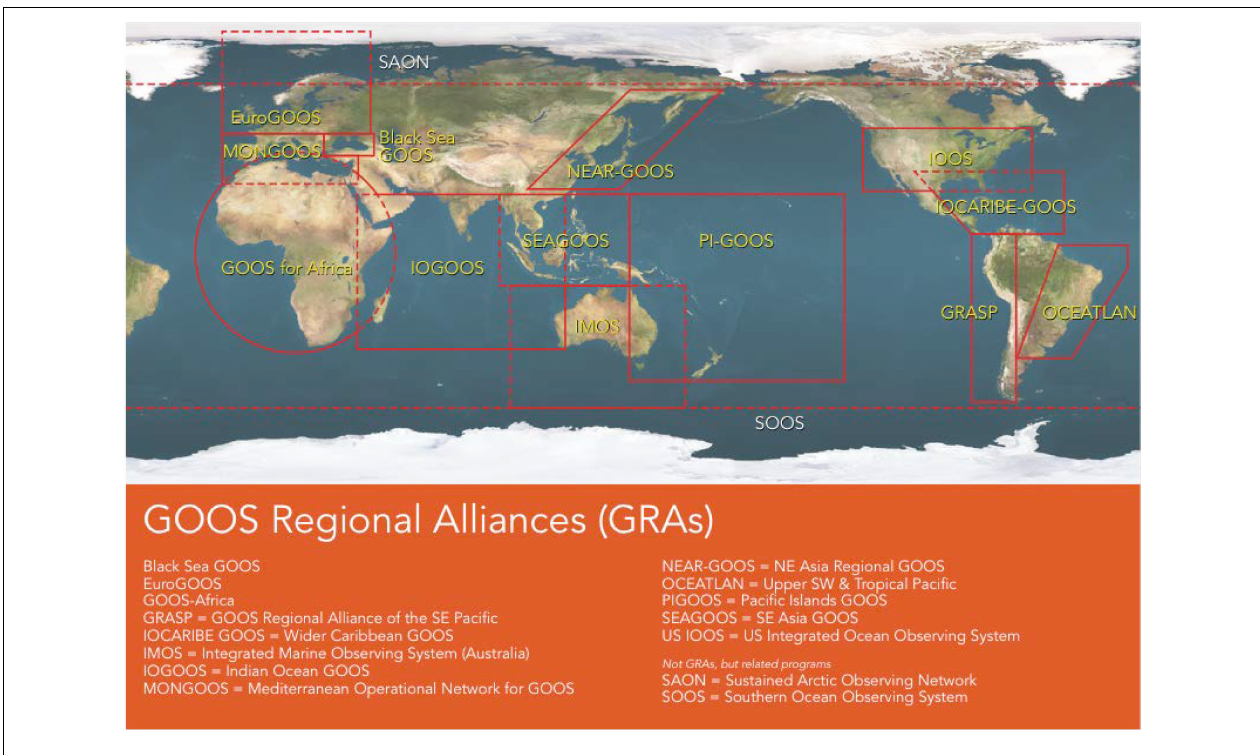
FIGURE 3 | GOOS Regional Alliances